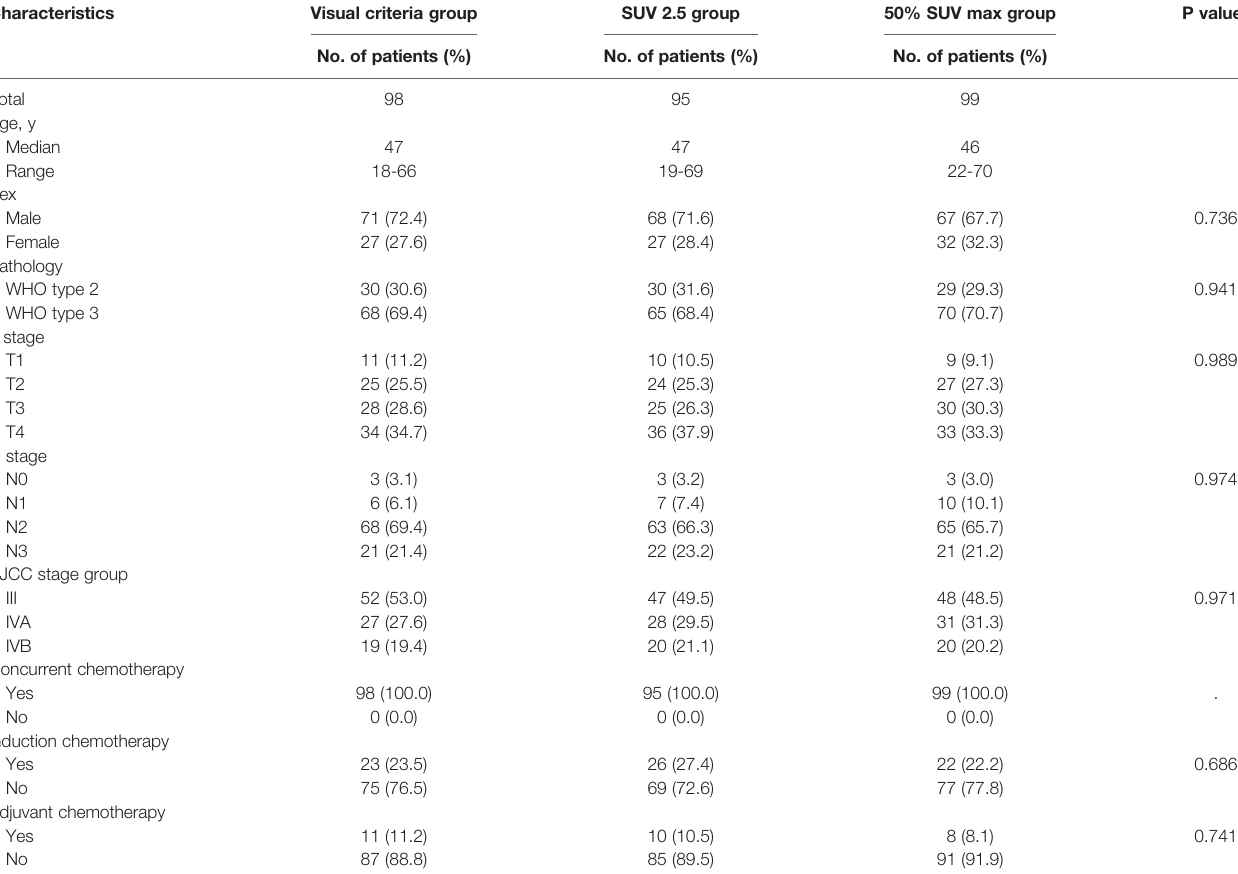
TABLE 1 | Clinical demographics of patients with loco-regionally advanced NPC. Characteristics